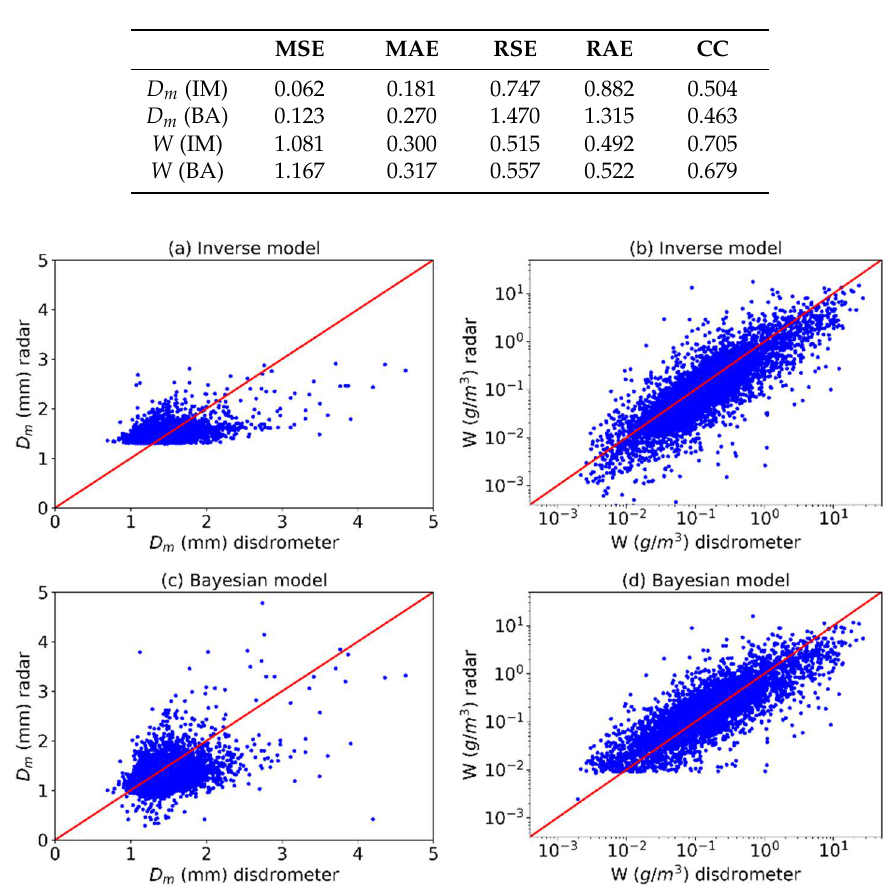
Figure 11. Same as Figure 10, but for real radar data.